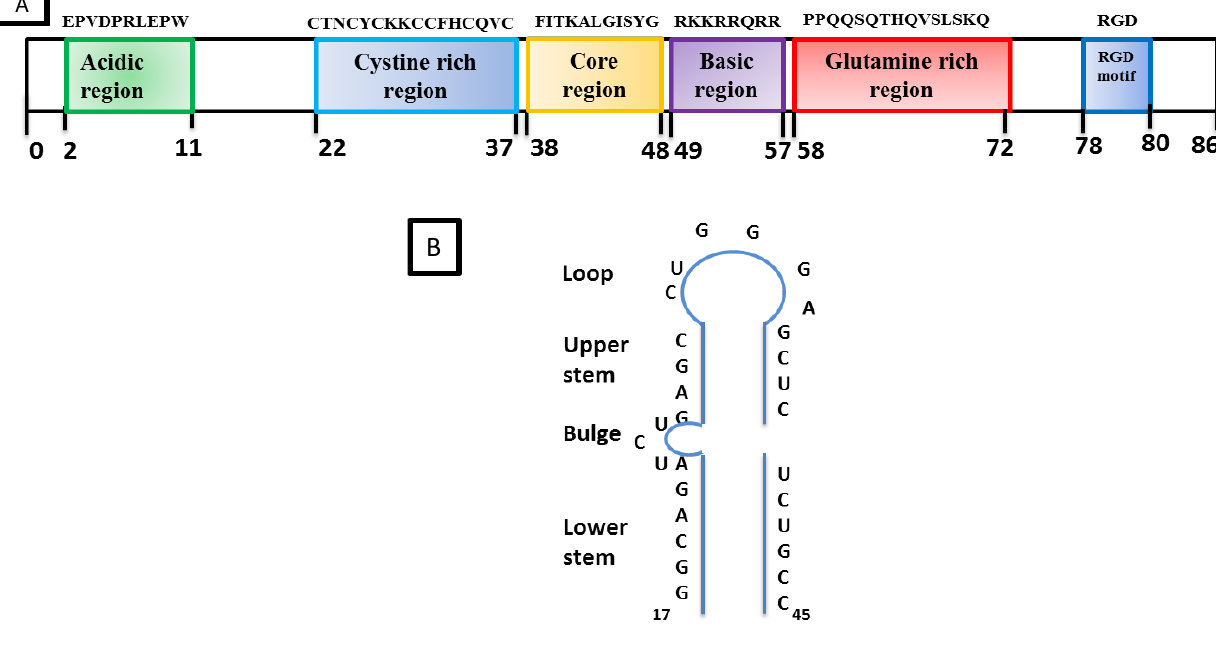
Figure 4. Structural organization of Tat and TAR: ( A ) The boxes in different colors indicate the position of the six different domains in the amino acid sequence of HIV-1